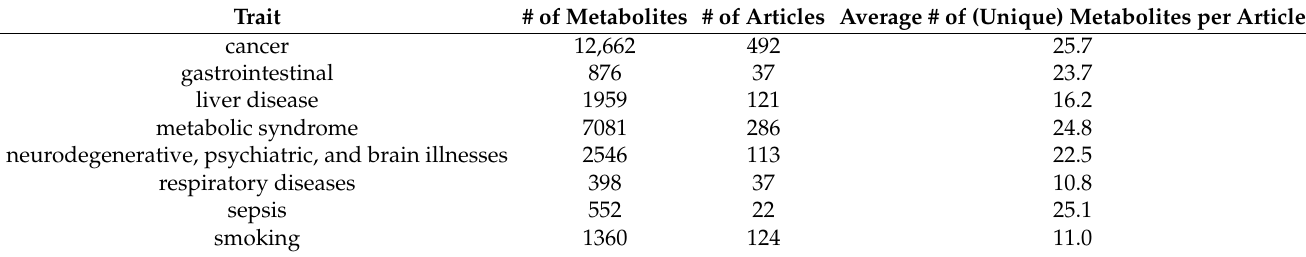
Table 2. Summary of the number (#) of unique metabolites annotated per trait. Each metabolite is only counted once per